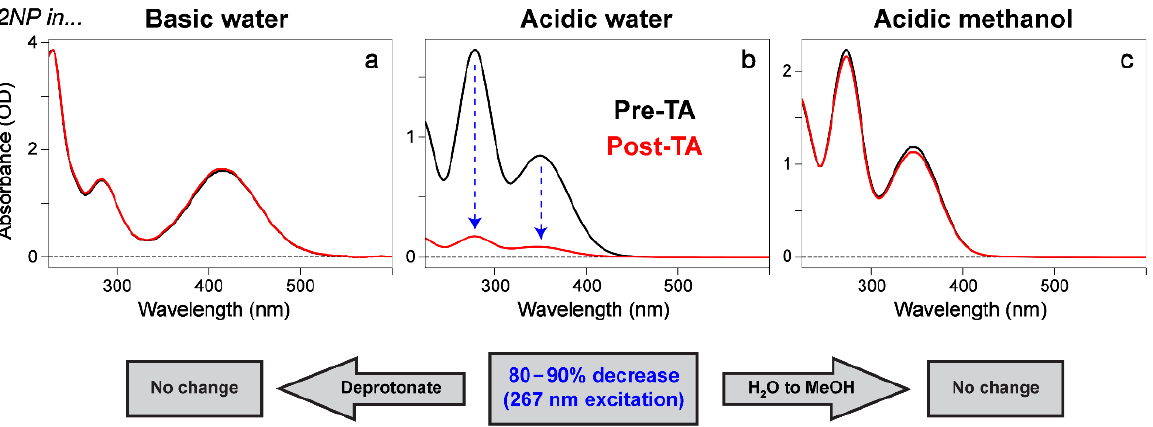
Figure 7. Changes in the electronic absorption spectra of 2NP after fs-TA experiments with 267 nm excitation in ( a ) basic water, ( b ) acidic water, and ( c ) acidic methanol. The baseline from the 550–600 nm region was subtracted from all the spectra for a more accurate comparison. The significant signal re- duction magnitude in acidic water is ~80–90%, but is not uniform across all the wavelengths covered. The other two conditions show no clear change in the absorption spectra after UV irradiation on the hour timescale (each TA experimental